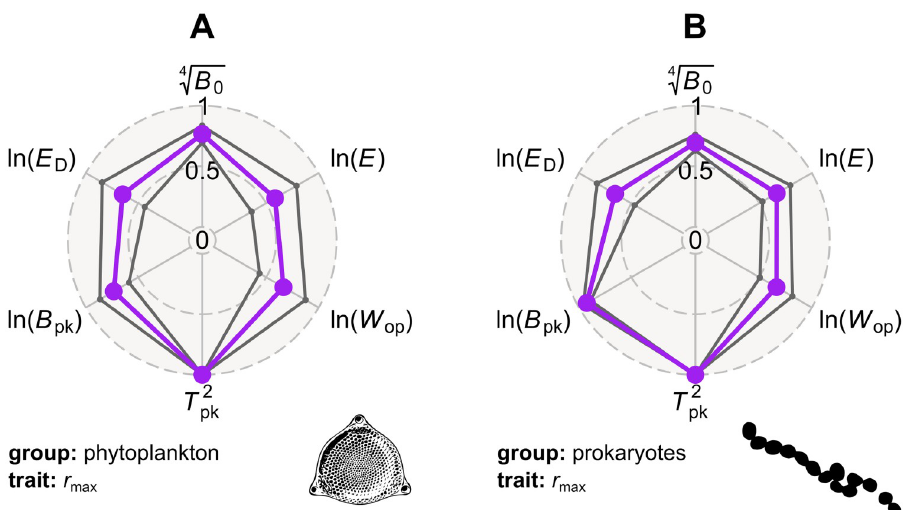
Fig 2. Moderate to strong phylogenetic heritability can be detected in all TPC parameters, across phytoplankton and prokaryotes. The 3 circles of each radar chart correspond to phylogenetic heritabilities of 0, 0.5, and 1. Mean phylogenetic heritability estimates—as inferred with MCMCglmm—are shown in purple, whereas the 95% HPD intervals are in dark grey. Note that we transformed all TPC parameters so that their statistical distributions would be approximately Gaussian. The data underlying this figure are available at https://doi.org/10.6084/m9.figshare.12816140. v1. HPD, highest posterior density; TPC, thermal performance